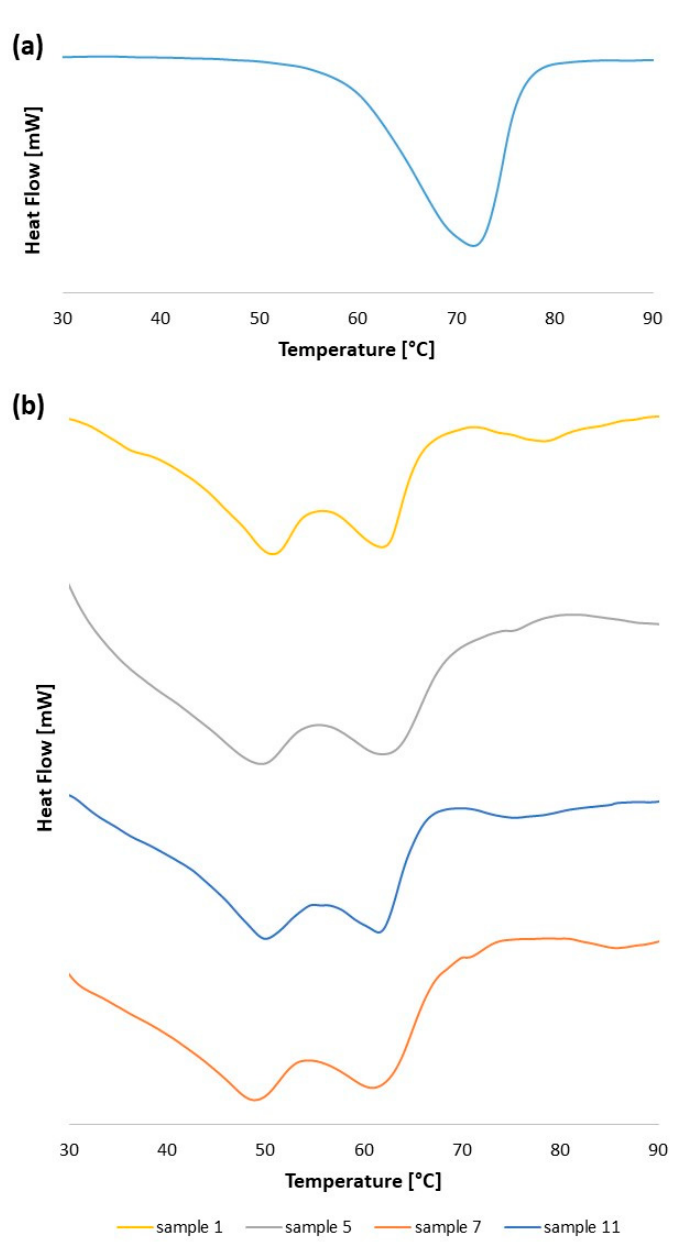
Figure 4. DSC thermograms of: ( a ) pure lipid material (glyceryl monostearate) and ( b ) optimized solid lipid nanoparticles (systems: 1, 5, 7, 11).